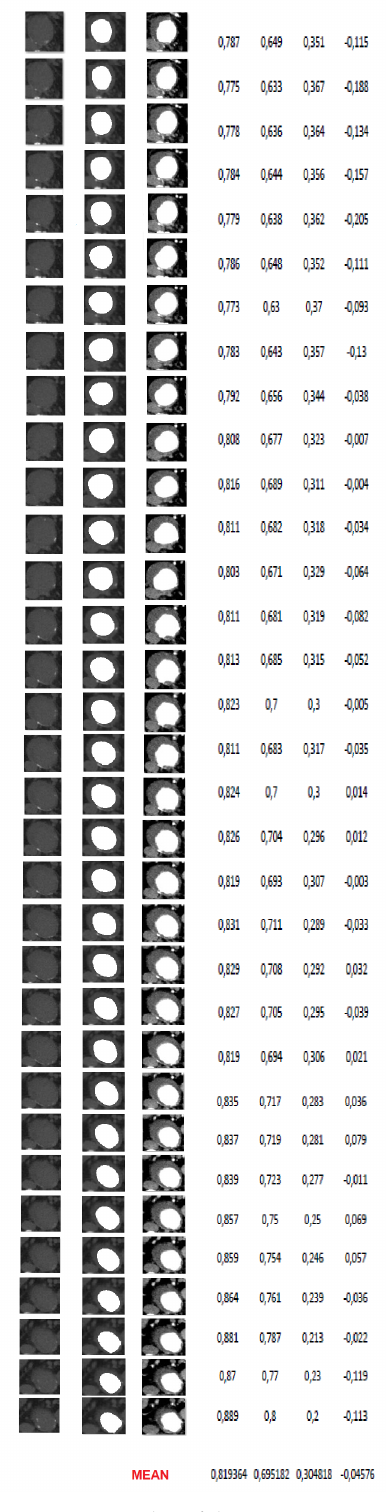
Figure 14. Results of the entire sequence of one of the 15 patients processed. On the left, the basal CT images of the vessel (NO CM), on the right, the CT images of the vessel with the contrast medium (CM), in the center, the reconstructions with the extraction of the patent lumen (i.e., the processed image, C SK ). Next to each slice, we report some of the most significant errors (Dice Coincidence Index, Tanimoto Index, misclassification error and bias